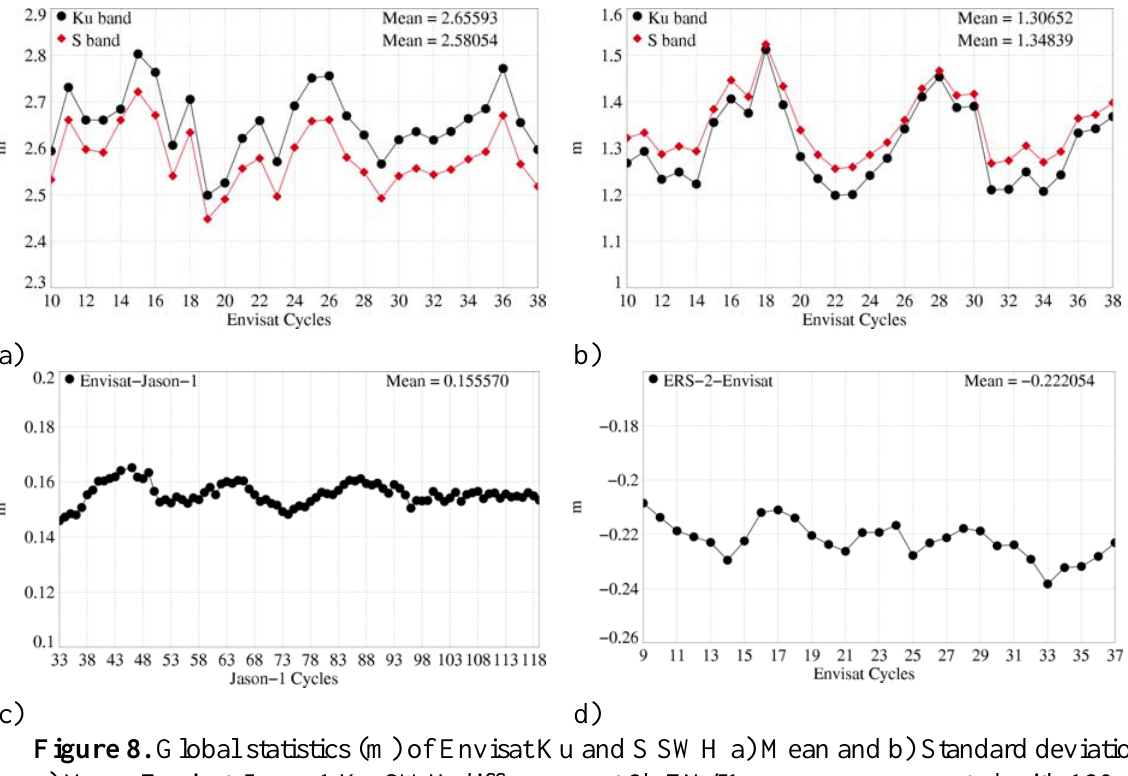
Figure 8. Global statistics (m) of Envisat Ku and S SWH a) Mean and b) Standard deviation. c) Mean Envisat-Jason-1 Ku SWH differences at 3h EN/J1 crossovers computed with 120 days running means. d) Mean. ERS-2-Envisat Ku SWH collinear differences over the Atlantic